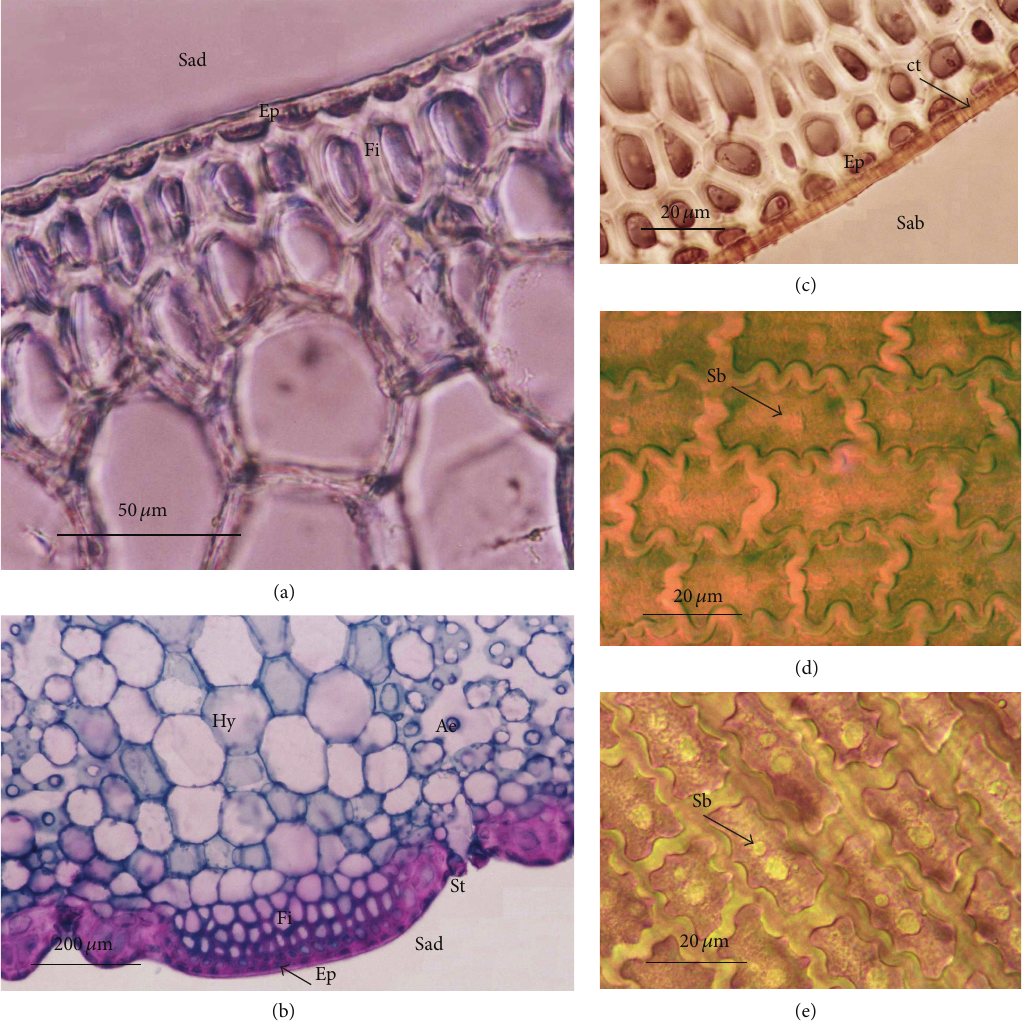
Figure 1: Leaf blade of Dyckia brevifolia Baker, as observed in light microscopy. ((a), (b), and (c)) Cross sections. ((d)–(e)) Epidermis frontal view. (a) Flat adaxial surface. (b) Abaxial surface with bumps and depressions. (c) Adaxial surface. (d) Abaxial surface. (e) Abaxial surface, showing the epidermis and subepidermal sclerified cells (fibers) in the coastal zone. (Ae = aerenchyma; Cl = chlorenchyma; Sc = siliceous body; Ct = cuticle; Ep = epidermis; St = stomata; Sab = abaxial surface; Sad = adaxial surface; Fi = fibers; Hy =